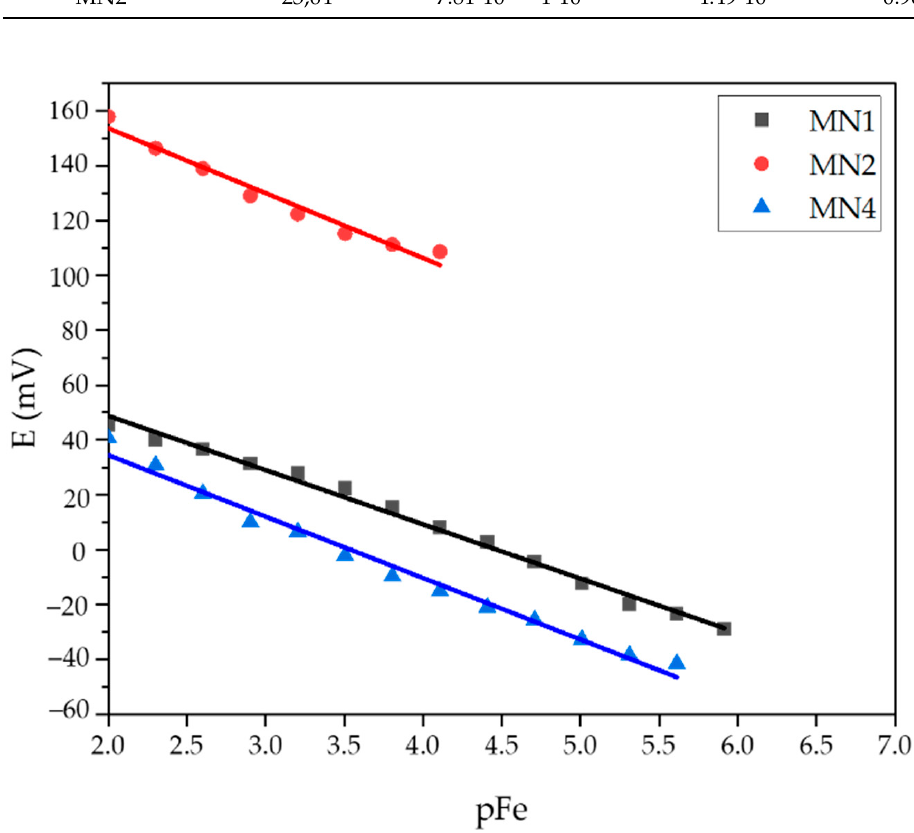
Figure 14. Potential change dependence of pFe evaluated for MN1, MN2, and MN4 membranes. The MN4 membrane with 0.25% magnetite NPs showed linearity in the determination of iron cations in the concentration range of 2.44 · 10 − 6 to 10 − 2 mol L − 1 with a slope of − 22.38 mV per concentration decade and a correlation factor of 0.9853. The detection limit for this membrane was 1.85 · 10 − 6 mol L − 1 . The MN1 and MN2 membranes contained 0.25% and 0.50% hematite NPs, respectively. The MN2 membrane, with 0.50% hematite showed − 23.64 mV per decade slope in the range from 7.81 × 10 − 5 to 10 − 2 mol L − 1 of ferric cations